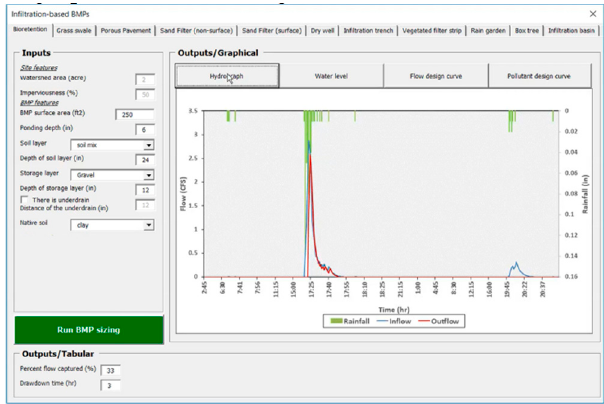
Figure A16. Output hydrograph for green roof system